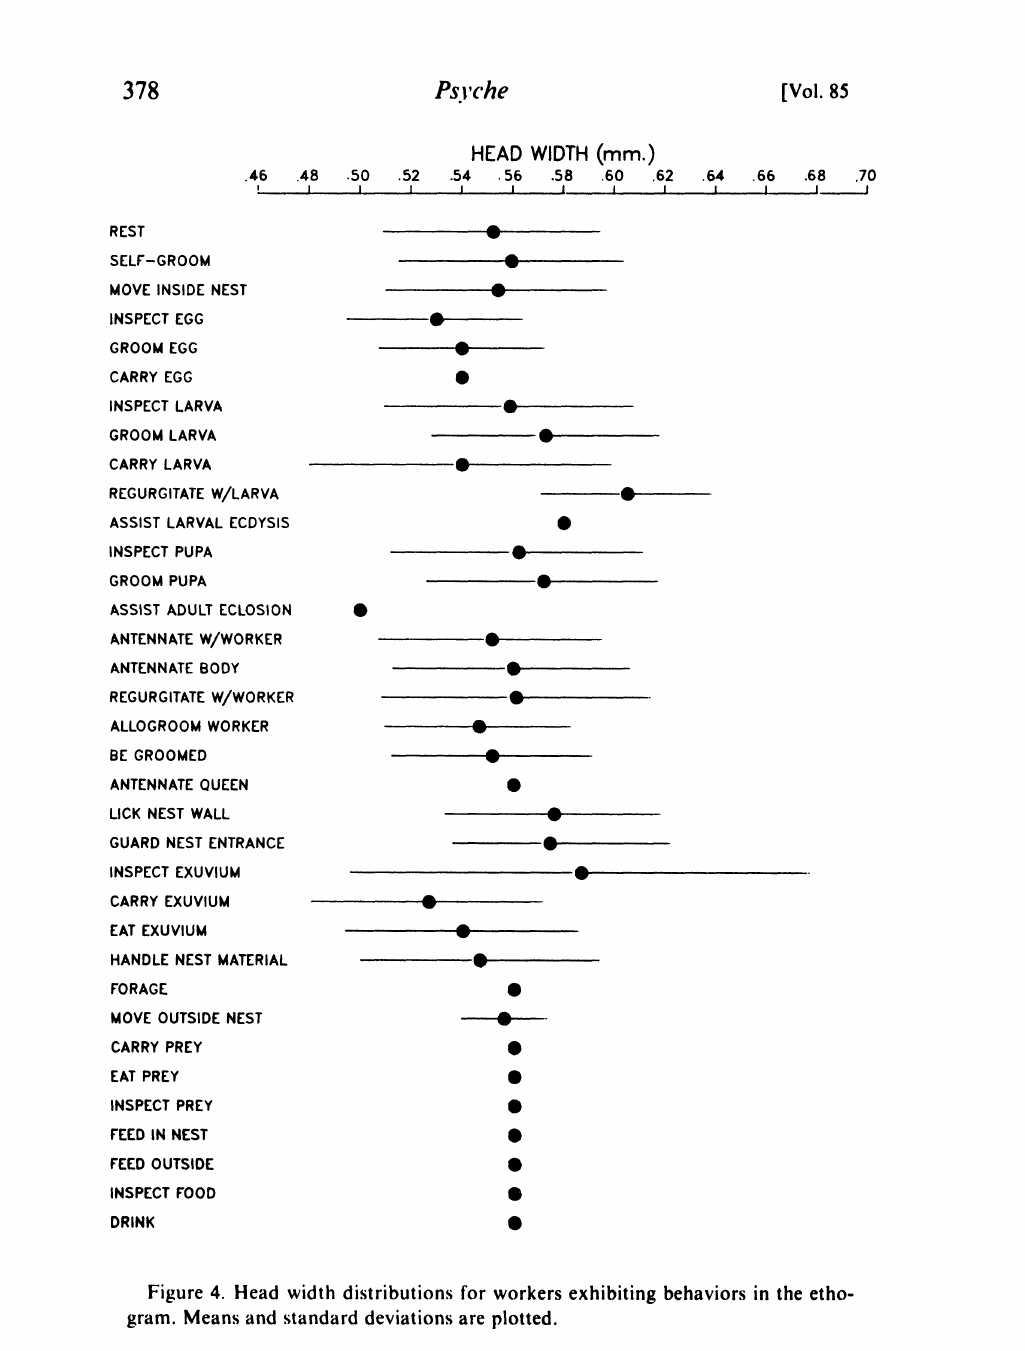
Figure 4. Head width distributions for workers exhibiting behaviors in the etho- gram. Means and standard deviations are